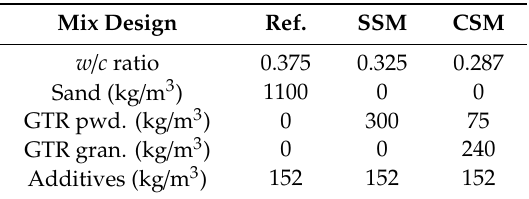
Table 3. Mix proportions of cementitious aggregates.